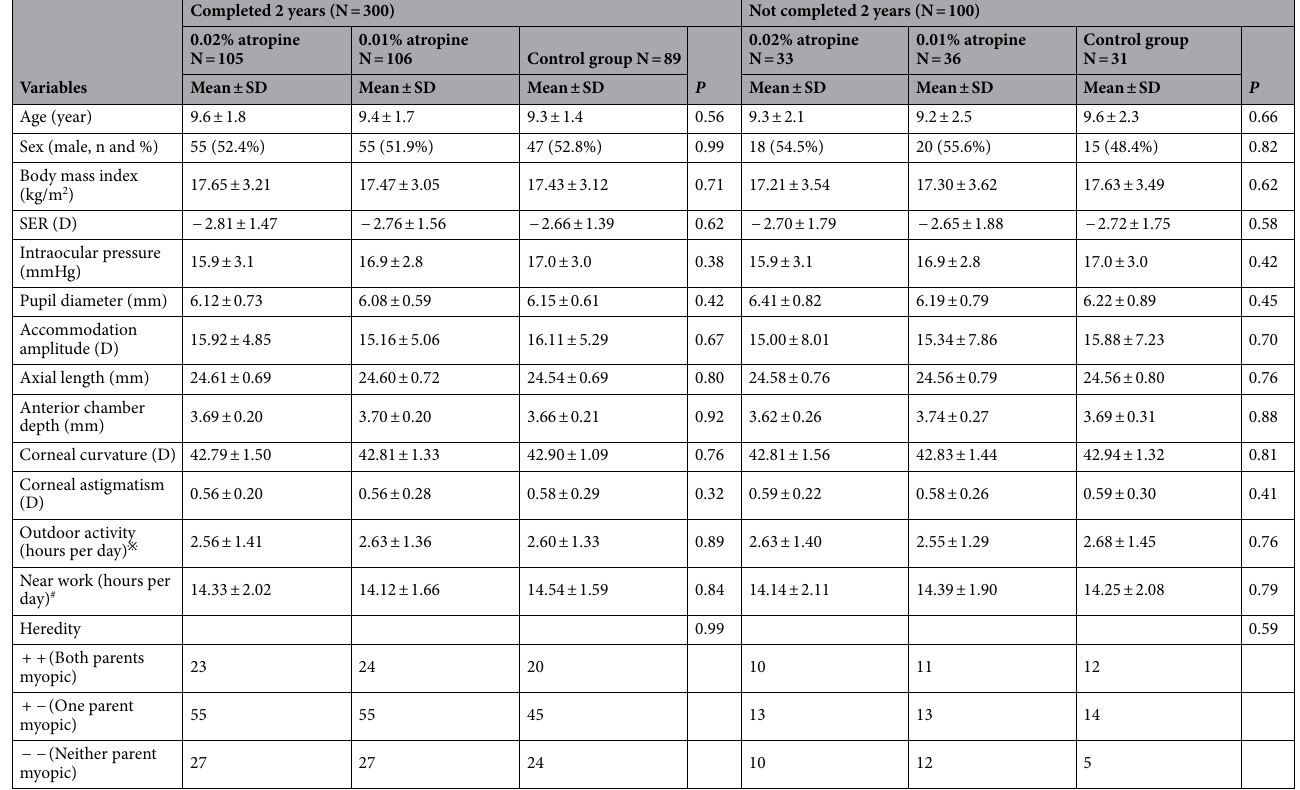
Table 1. Baseline characteristics of study participants who completed 2 years versus those who have not completed 2 years. There were no significant differences observed those who completed and did not (using computer + playing video game) + 1 * (watching TV).